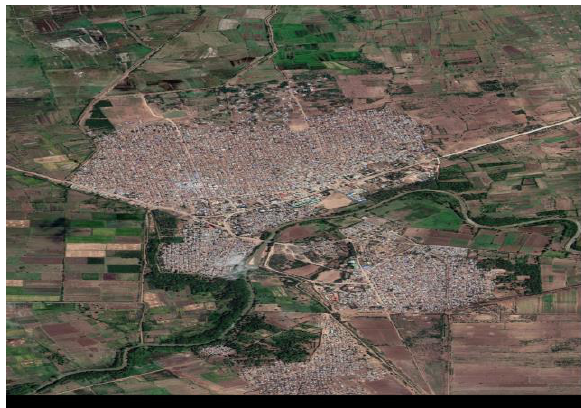
Figure 6. Jowhar original image on April 2020